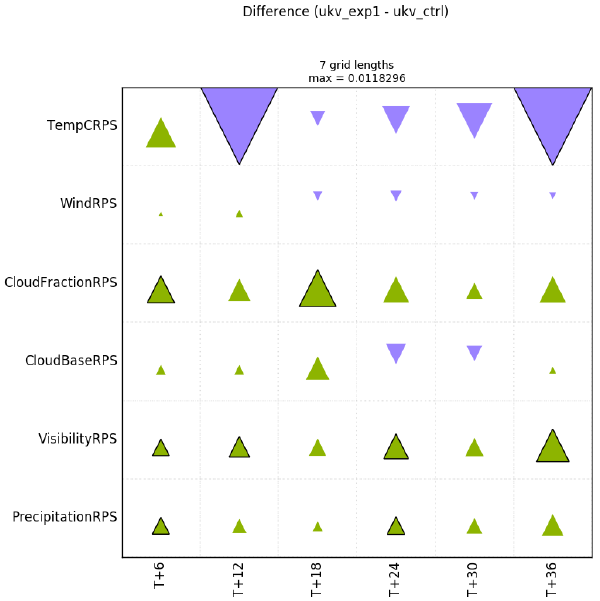
Figure 7. HiRA summary scorecard at 10.5km (seven grid lengths) spatial scale for UKV case studies run with improved ice cloud frac- tion in mixed phase clouds. HiRA uses synoptic observations (see Sect.